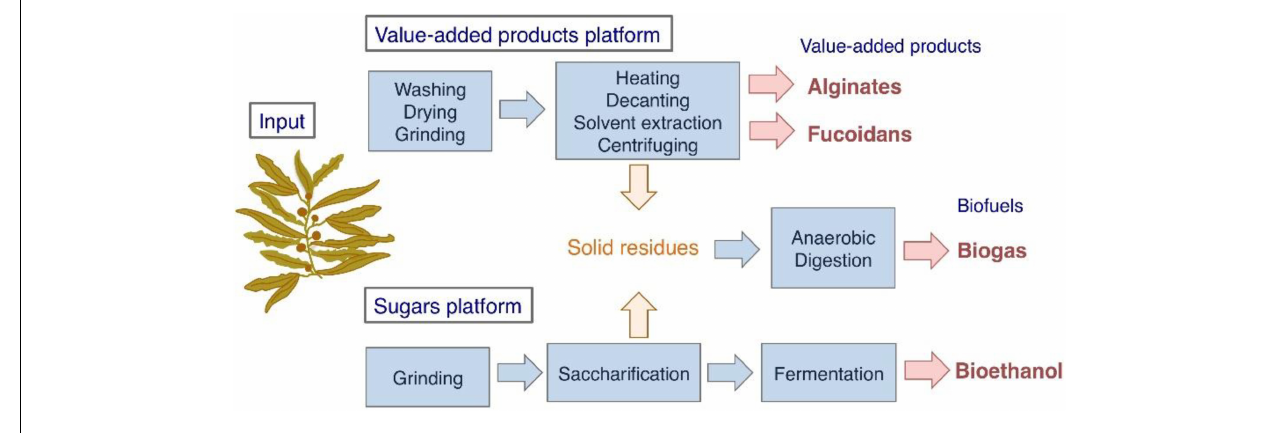
FIGURE 9 | Proposed platforms for a sargasso biorefinery.